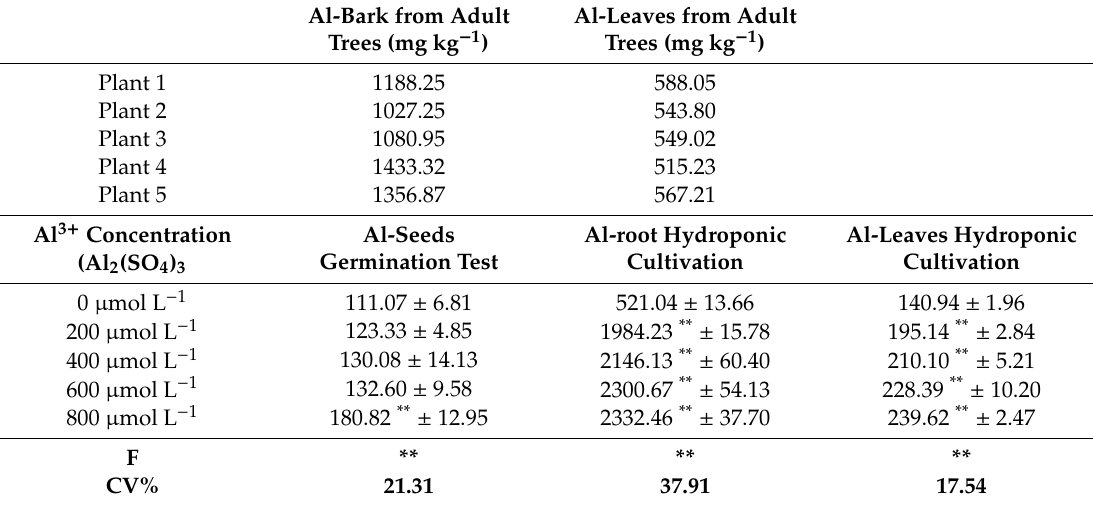
Table 5. Eugenia dysenterica Al content in seedlings (Al-Bark and root), seeds from the germination test (Al-Seeds), hydroponic roots grown in solution (Al-Root), leaves grown in solution (Al-Leaf) after 20 days of hydroponic growth at di ff erent Al concentrations (0, 200, 400, 600 and 800 µ mol L − 1